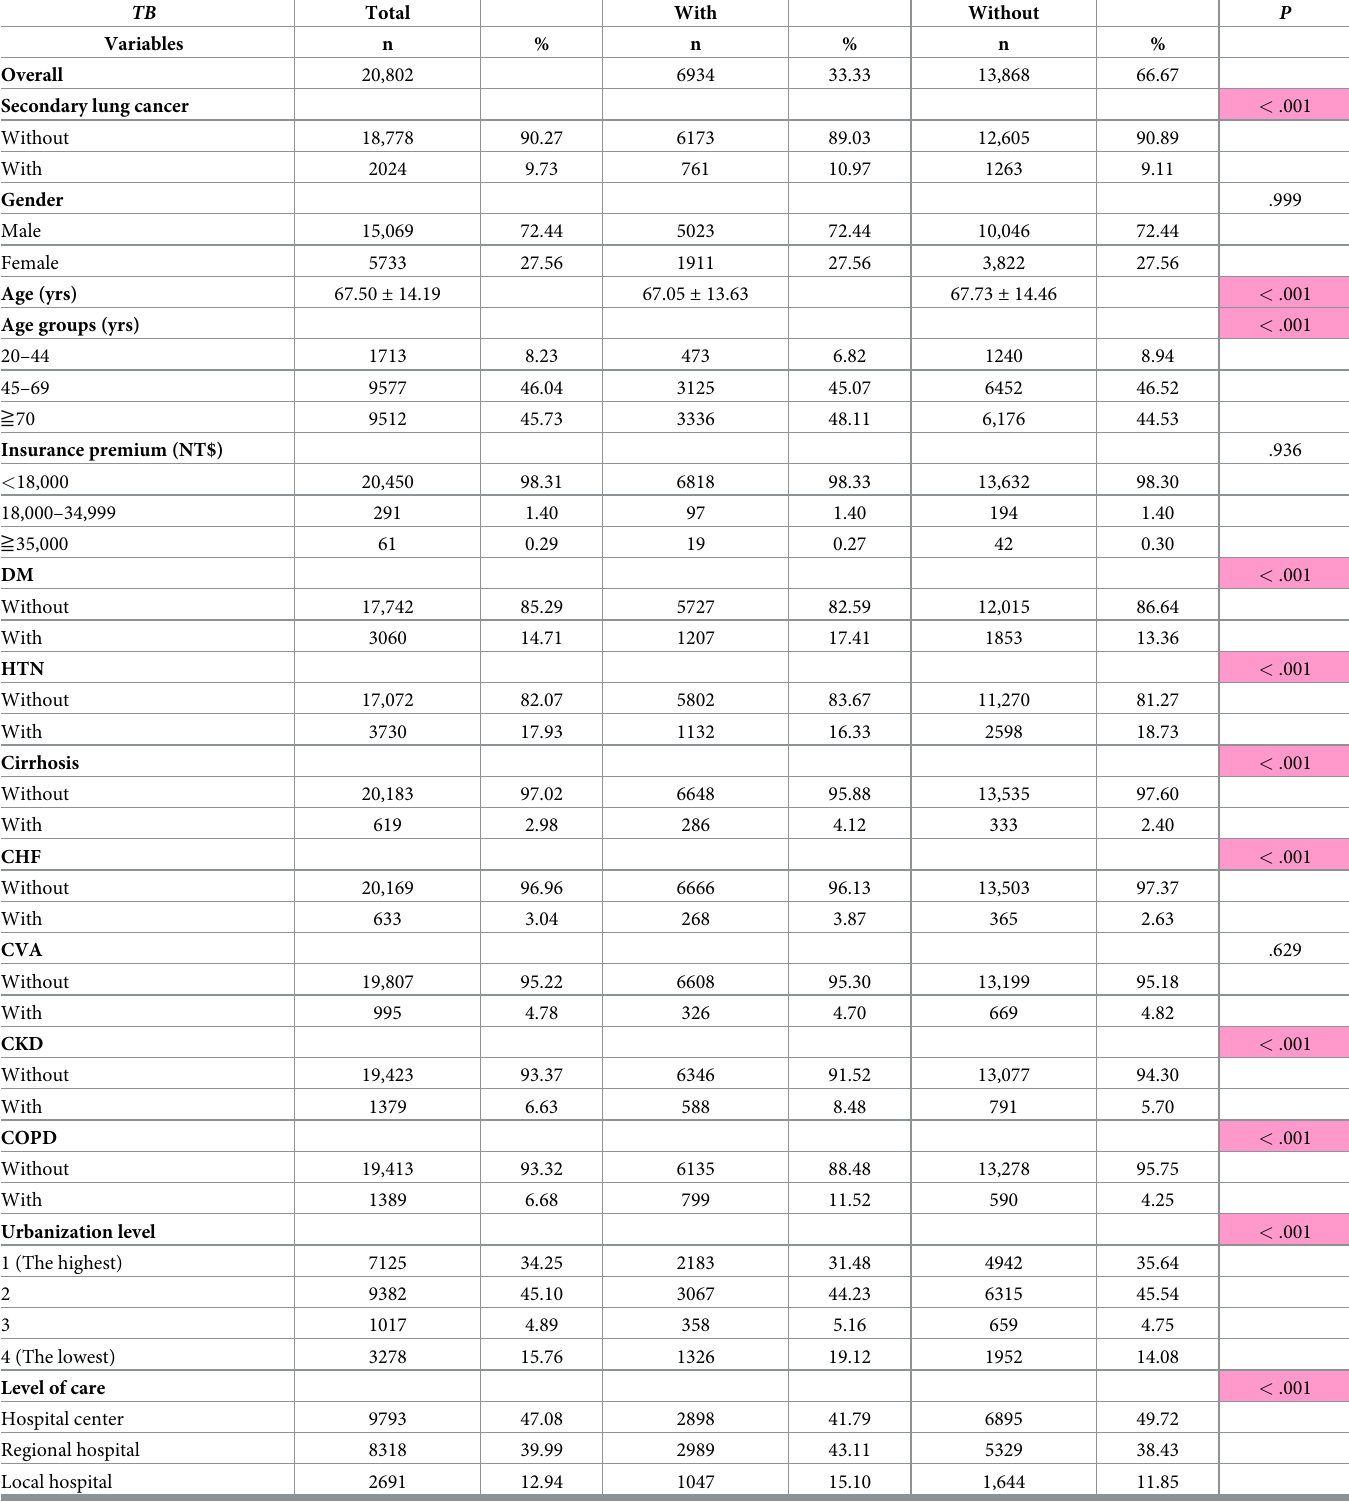
Table 1. Demographic characteristics and comorbidities of study